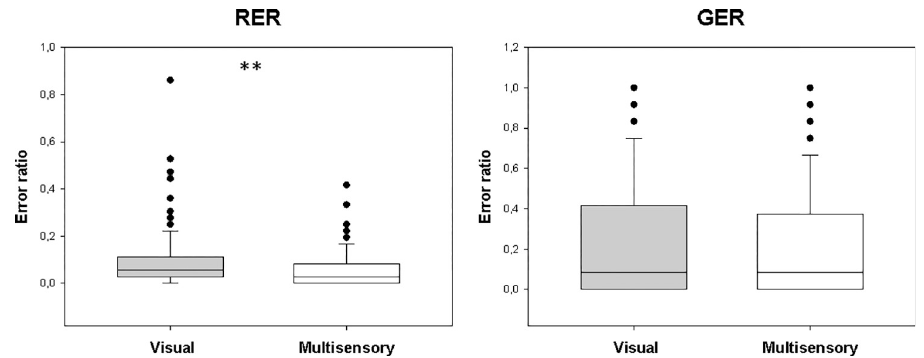
Fig 4. Performance in the test phase of the visual and audiovisual paradigms. The test phase can be divided into two parts, retrieval and generalization (see text for details) Performance in these parts is characterized by the retrieval error ratio (RER) and generalization error ratio (GER). RER differed significantly between the paradigms at p < 0.01, while GER did not differ significantly between the paradigms. The conventions are the same as in Fig